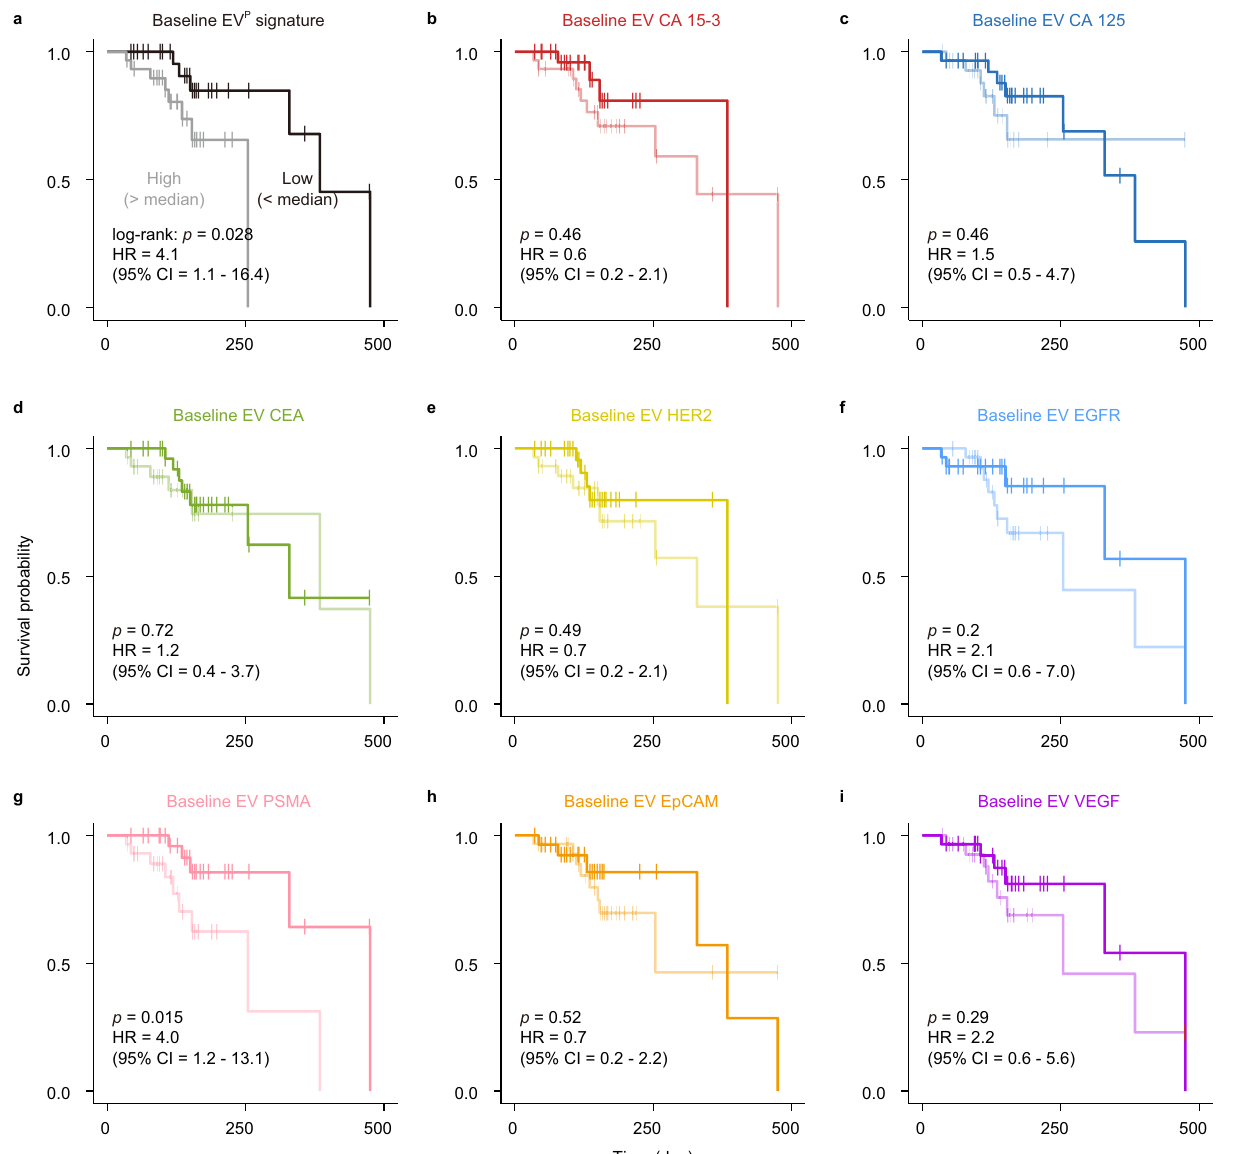
Fig. 7 EV protein markers for prediction of progression-free survival (PFS) in a MBC cohort. Kaplan – Meier curves showing PFS of 59 MBC patients according to the EV P signature ( a ), CA 15-3 ( b ), CA 125 ( c ), CEA ( d ), HER2 ( e ), EGFR ( f ), PSMA ( g ), EpCAM ( h ), and VEGF ( i ) on EVs before treatment (baseline). The baseline level (high or low) was strati fi ed according to the median value. The signi fi cance of the difference was calculated by a two-sided log-rank test. Hazard ratio (HR) and 95% CI were calculated using Cox proportional-hazard regression with a univariate model. Source data are provided as a Source Data fi